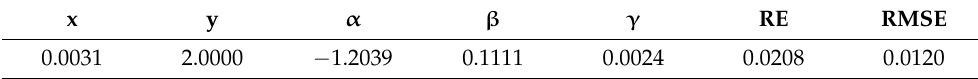
Table 2. The parameters of the model.